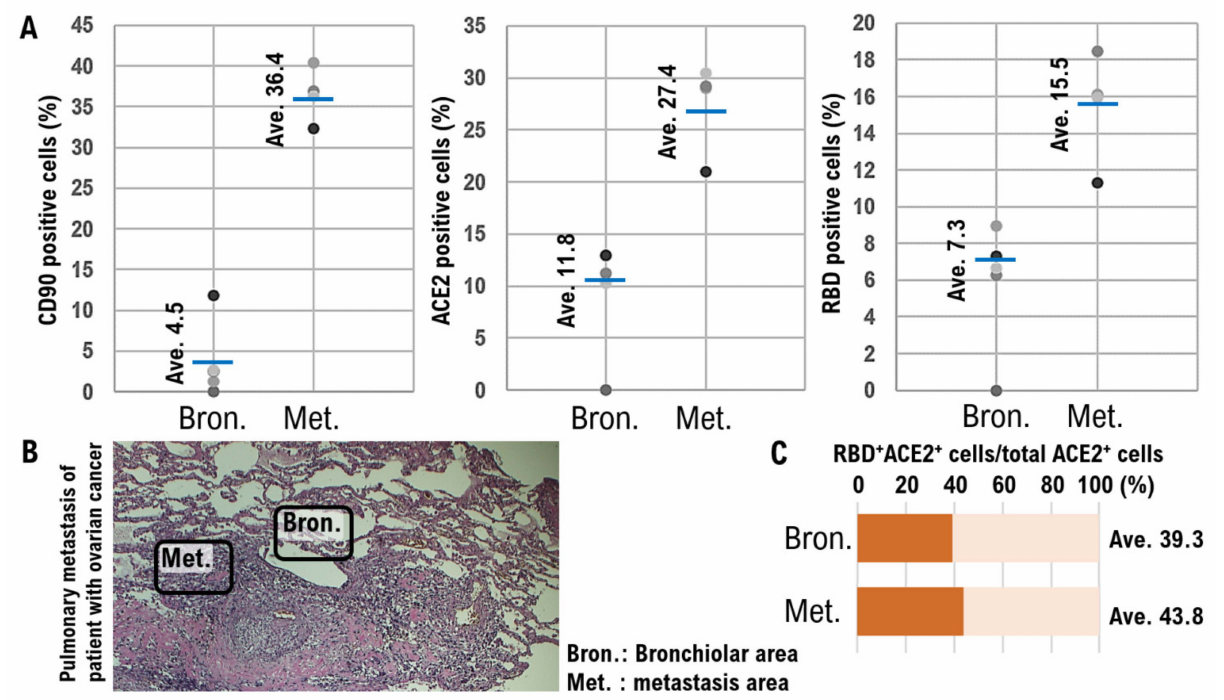
Figure 2. Quantification of immunofluorescence colocalization in imaging for CD90 and ACE2 expression levels and RBD binding. A quantitative analysis was conducted using ImageJ Version 1.53 m, a public domain software for image analysis (NIH ImageJ, Bethesda, MD, USA). The CD90 and ACE2 expression levels and the binding of RBD in normal alveolar and bronchiolar areas (Bron.) and metastases areas (Met.) were investigated through pathological studies. ( A ) The ratios of the number of target protein-positive cells to the total number of cells are shown in the dispersion diagram. ( B ) Photographs of the normal alveoli and bronchioles areas (Bron.) and metastases areas (Met.) from a tissue section of lung metastases resected from a patient with ovarian cancer. The expression levels of each factor were determined by measuring fluorescence intensities. ( C ) The proportion of bronchiolar epithelial cells associated with RBD of SARS-CoV-2 in normal alveoli and bronchiolar regions is indicated as the ratio of RBD-positive cells to total cell